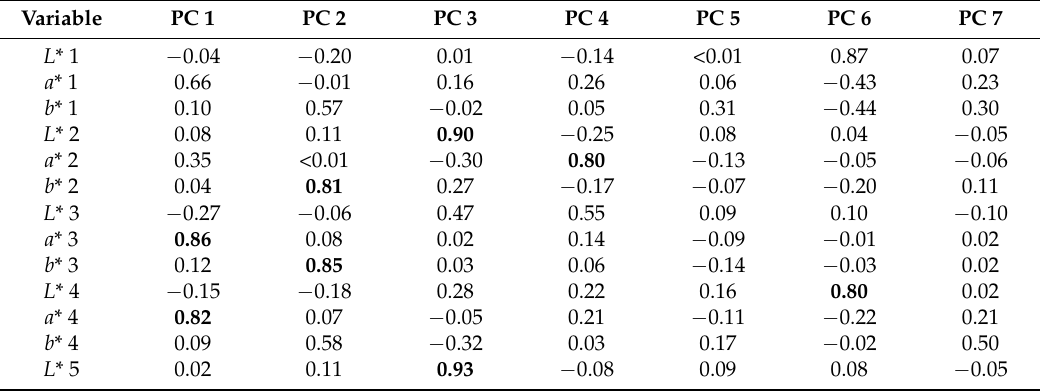
Table A2. Axis loadings of the principle component analysis (PCA) analyzing male body coloration (wild-caught males from all populations considered in this study) after Varimax rotation. Axis loadings > 0.75 are highlighted in